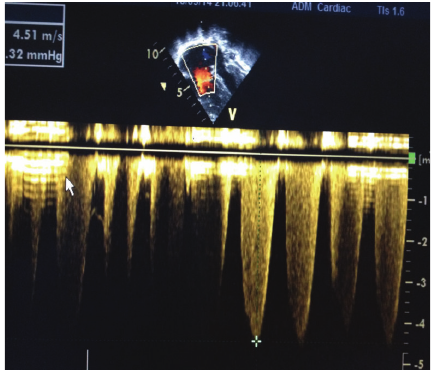
Figure 2: + shows maximum velocity (4.51m/sec) equivalent to the pressure gradient of 81 mmHg which indicates severe pulmonary hypertension before adenotonsillectomy.